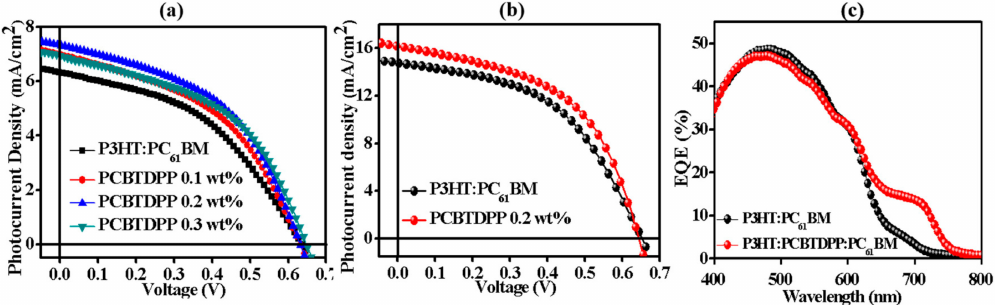
Figure 4. J-V curves of the devices based on ( a ) PEDOT:PSS (AI 4083) and ( b ) PEDOT:PSS (PH 500) with 5% DMSO and ( c ) EQE profiles of the devices based on P3HT:PC 61 BM and P3HT:PCBTDPP(0.2 wt.%):PC 61